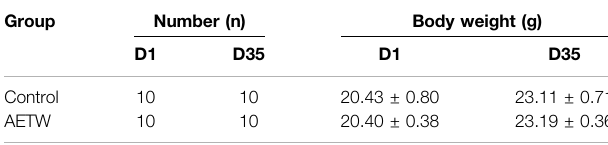
TABLE 3 | Tumor volume from mice of the two experiment groups (control, AETW). Group